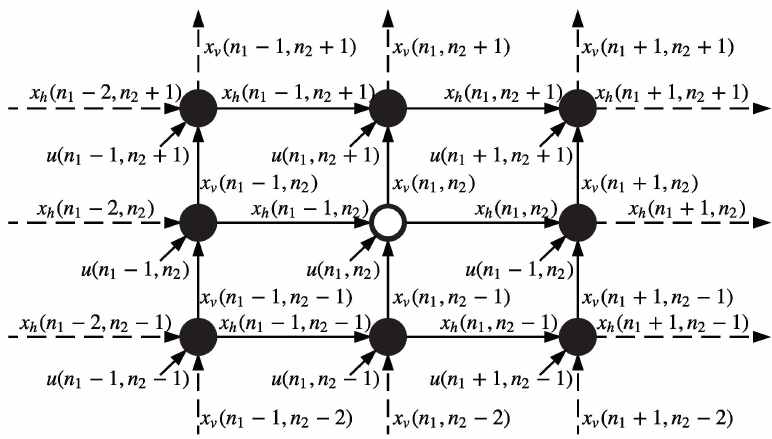
Figure 2. Standard 2-D Roesser model with first quadrant